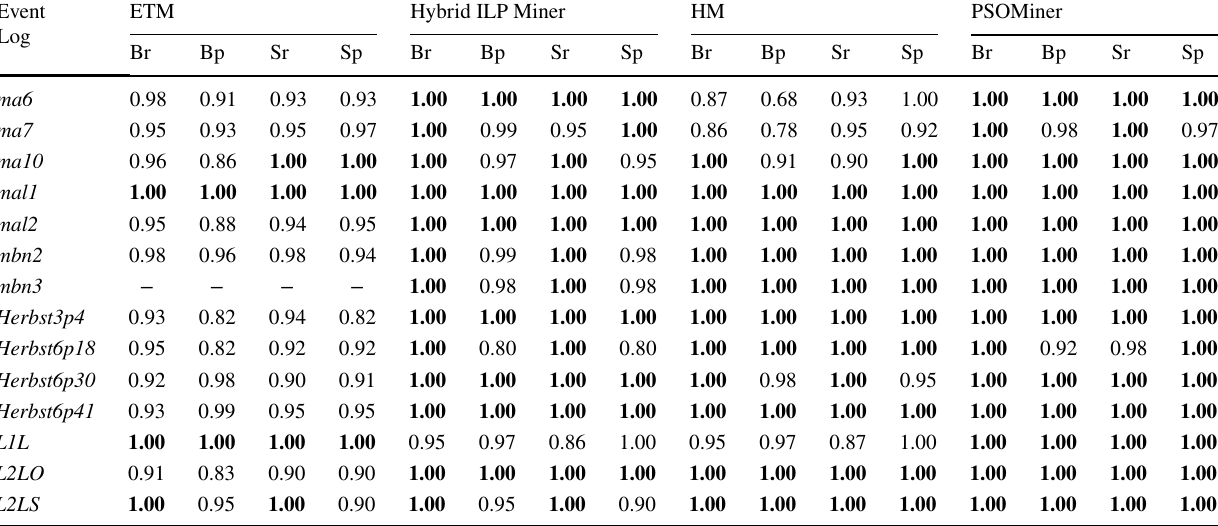
Table 4 Comparing PSOMiner with three state-of-art algorithms on noise-free event logs Event ETM Hybrid ILP Miner HM Log